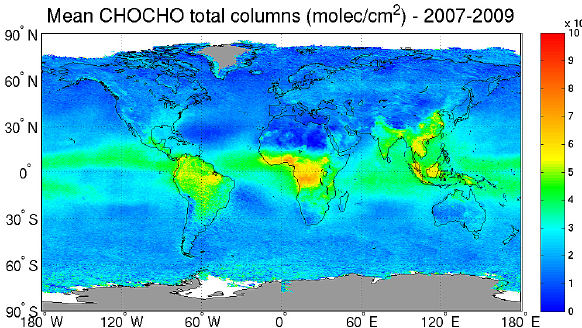
Fig. 9. Mean glyoxal vertical column densities retrieved from GOME-2 measurements between 2007 and 2009. Only pixels with cloud fraction lower than 0.4 are